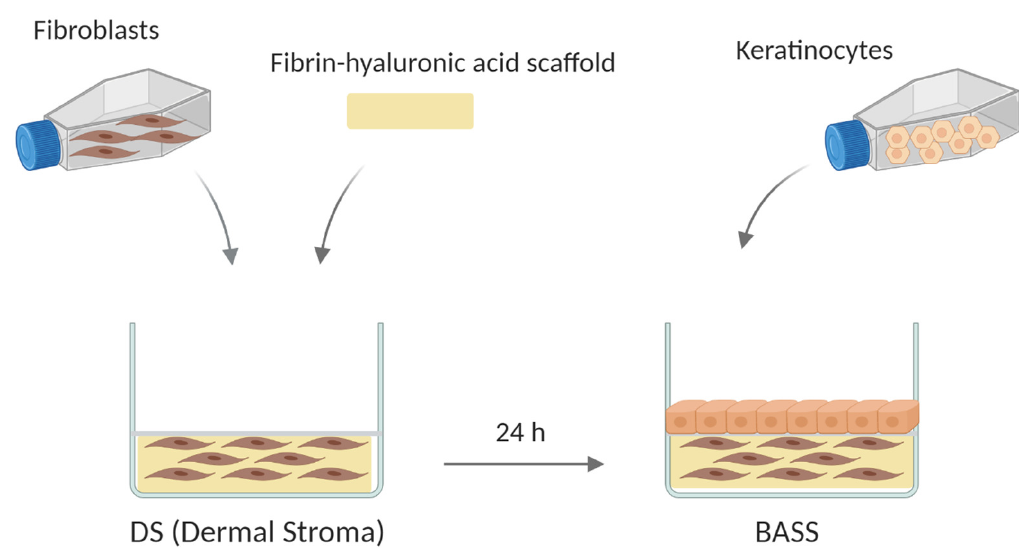
Figure 1. Schematic representation of the bioengineered artificial skin substitutes (BASS) manufacturing process. Created with BioRender.com .